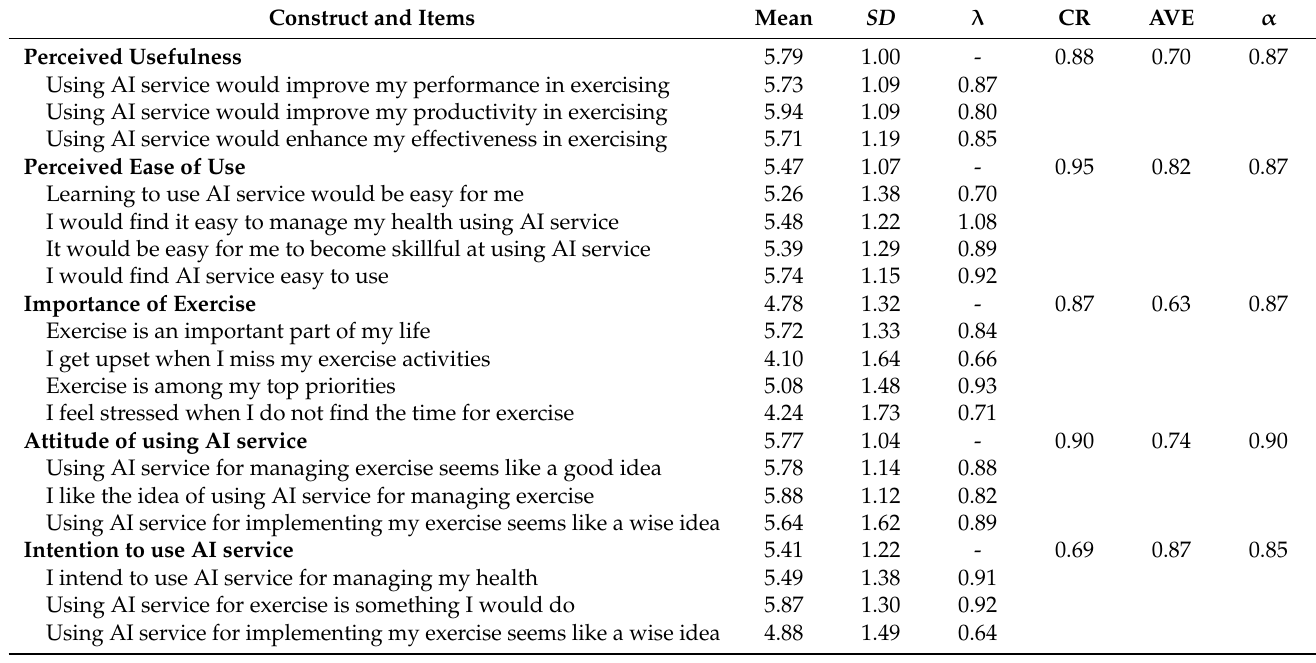
Table 1. Finalized survey questionnaire: Mean, Standard Deviation ( SD ), Factor Loading ( λ ), compos- ite reliability (CR), average variance extracted (AVE), and Reliability Coefficients ( α